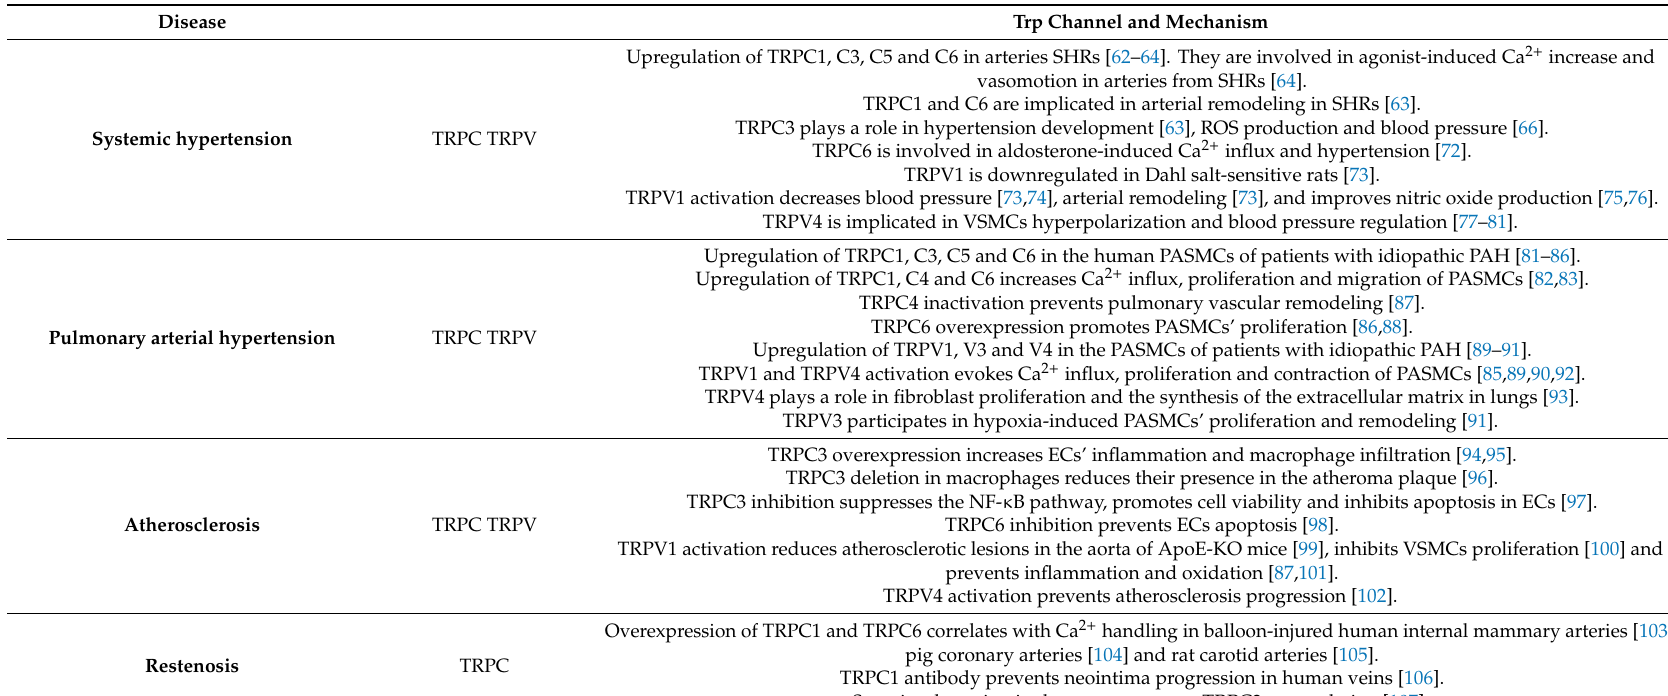
Table 1. List of TRPC and TRPV isoforms involved in vascular disease. ApoE — KO, Apolipoprotein E knock-out mice; ECs, Endothelial cells; NF- κ B, Nuclear factor kappa B; PAH, Pulmonary arterial hypertension; PASMCs, Pulmonary artery smooth muscle cells; ROS, Reactive oxygen species; SHRs, Spontaneously hypertensive rats; TRPC, Transient receptor potential canonical channel; TRPV, Transient receptor potential vanilloid-related channel; VSMCs, Vascular smooth muscle